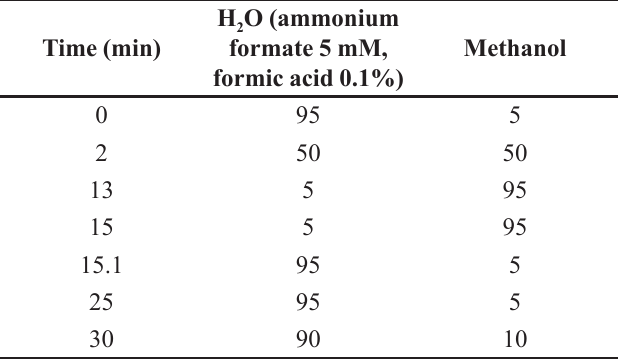
TABLE I - Gradient water: methanol used for HPLC separation H O (ammonium 2 Time (min) formate 5